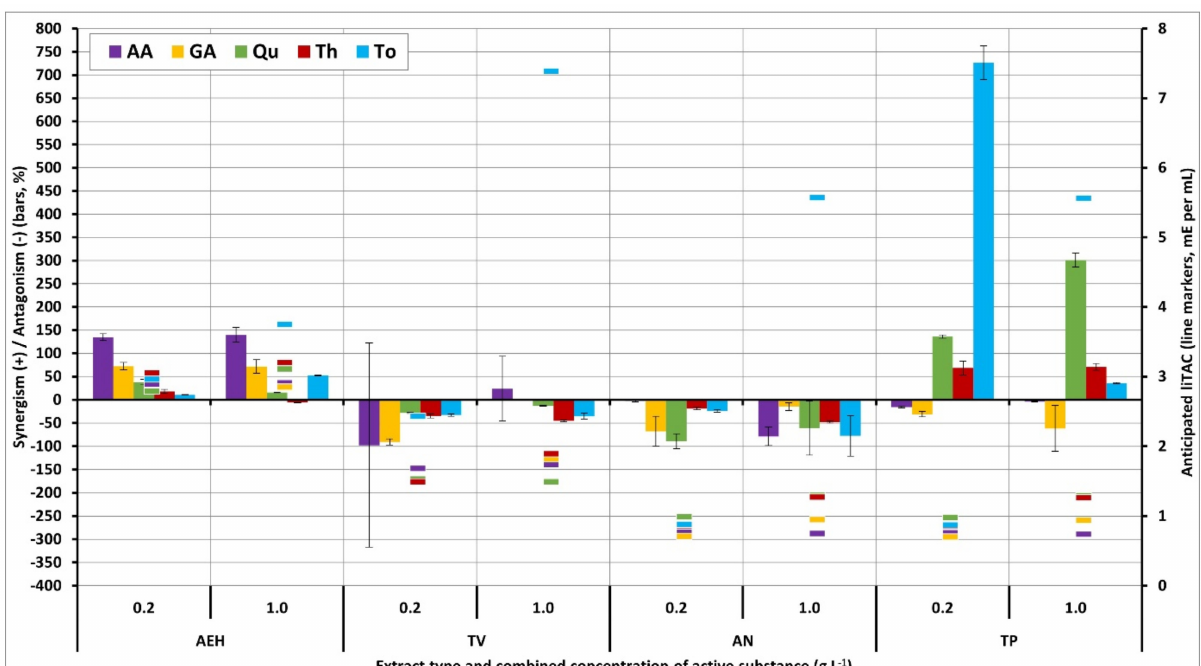
Figure 6. Base total antioxidant capacity (TAC) and determined synergistic effects of different plant-based extracts in combination with active standard substances, analysed via liTAC Assay. Primary ordinate (bars): synergistic (+) or antagonistic ( − ) effect of extract combinations ( n = 3; standard deviation indicated via error bars). Secondary ordinate (line markers): absolute base TAC, based on TAC determination of pure extracts/standard solutions ( n = 6) and subsequent mathematical accumulation. AA: ascorbic acid; GA: gallic acid; Qu: quercetin; Th: thymol; To: α -tocopherol; AN: Abies nordmanniana extract; TV: Thymus vulgaris extract; AEH: Aesculus hippocastanum extract; TP: tomato paste extract; mE: milli extinction